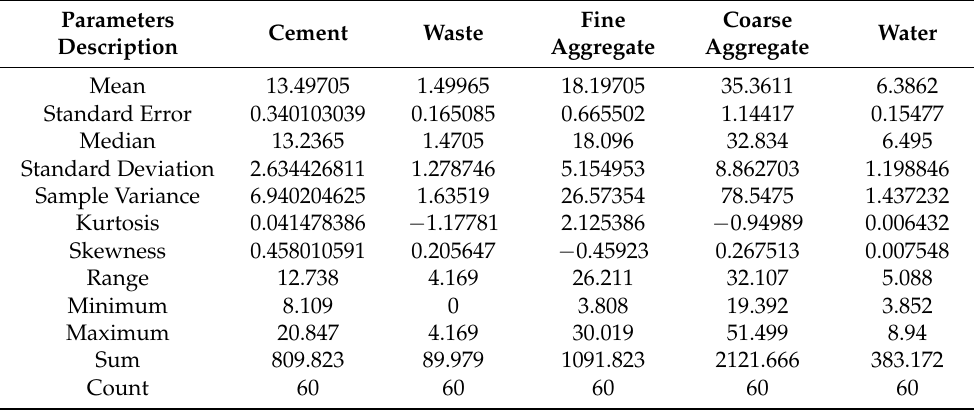
Table 5. Descriptive analysis of the parameters.